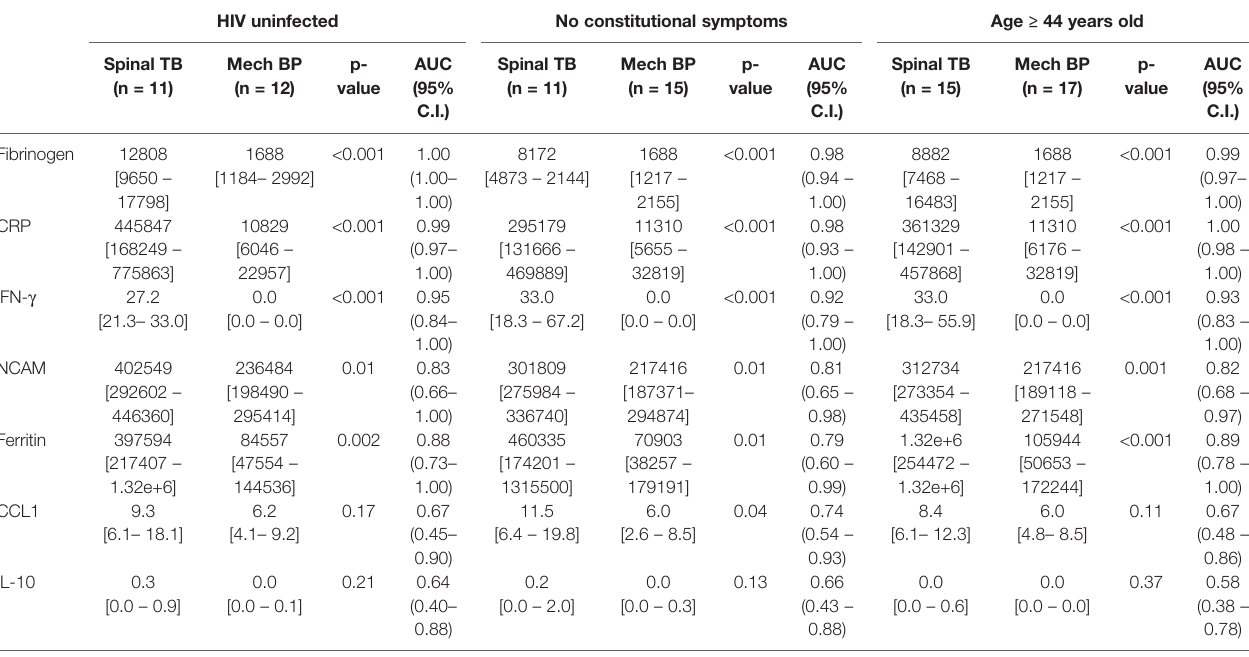
TABLE 6 | Biomarker levels and utility of individual biomarkers to distinguish between spinal TB and mechanical back pain in subgroups with no HIV infection, no constitutional symptoms or age 44 years and older. HIV uninfected No constitutional symptoms Age ≥ 44 years old Spinal TB Mech BP p-